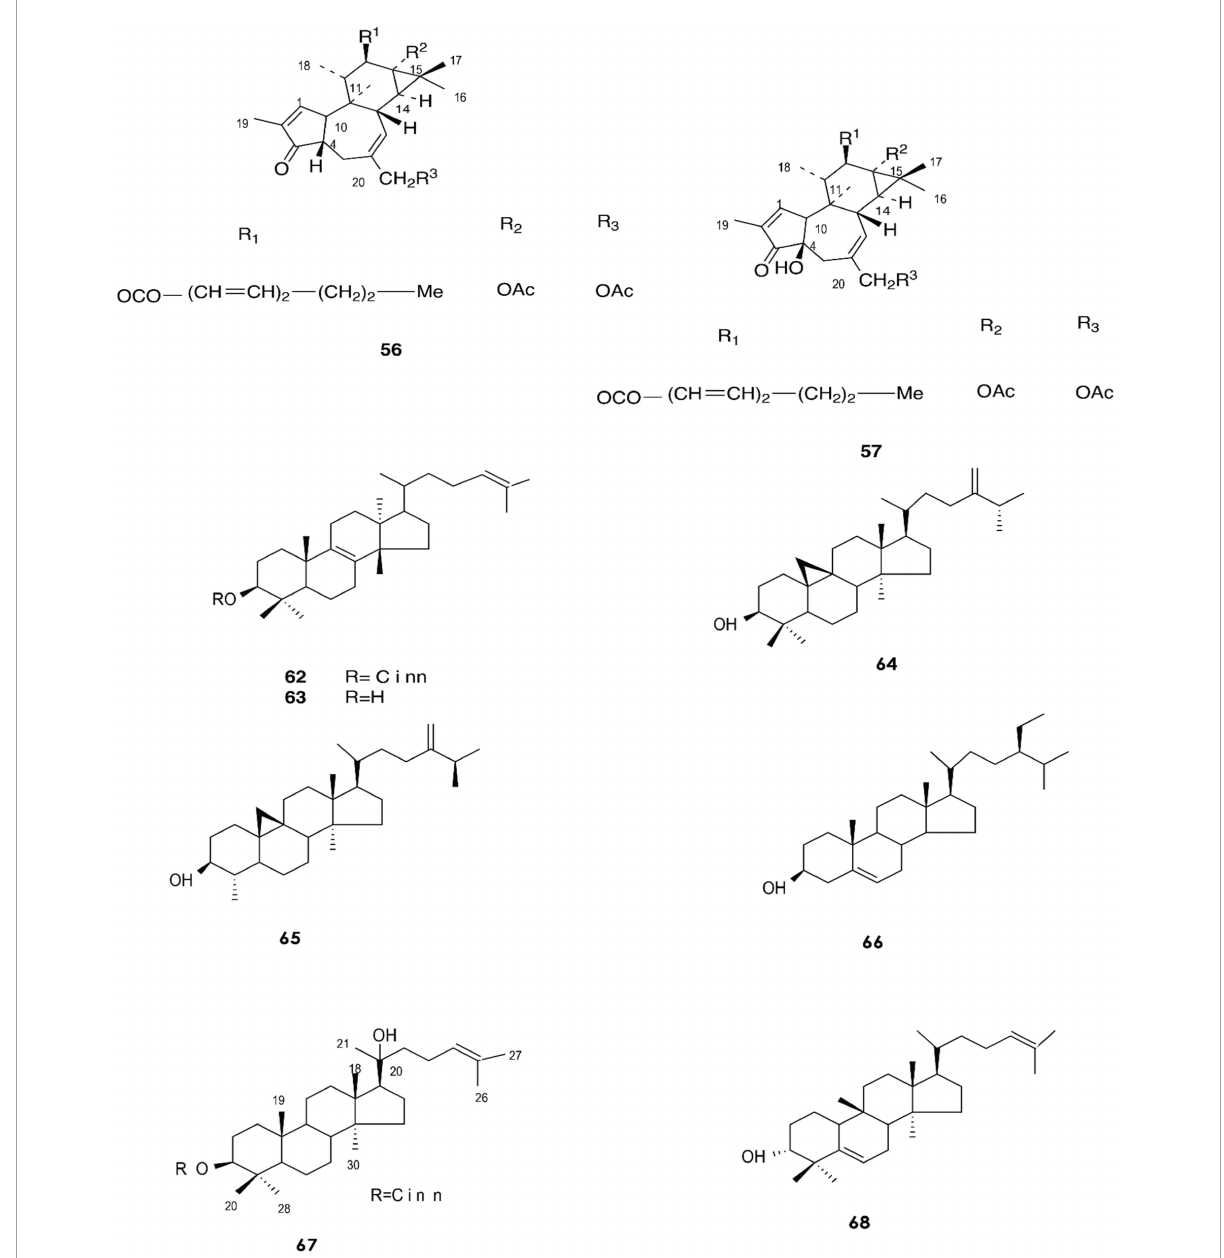
FIGURE3 Structure of chemicals compounds (56-57, 62-68) (Urones et al., 1988; Gewali et al., 1990).